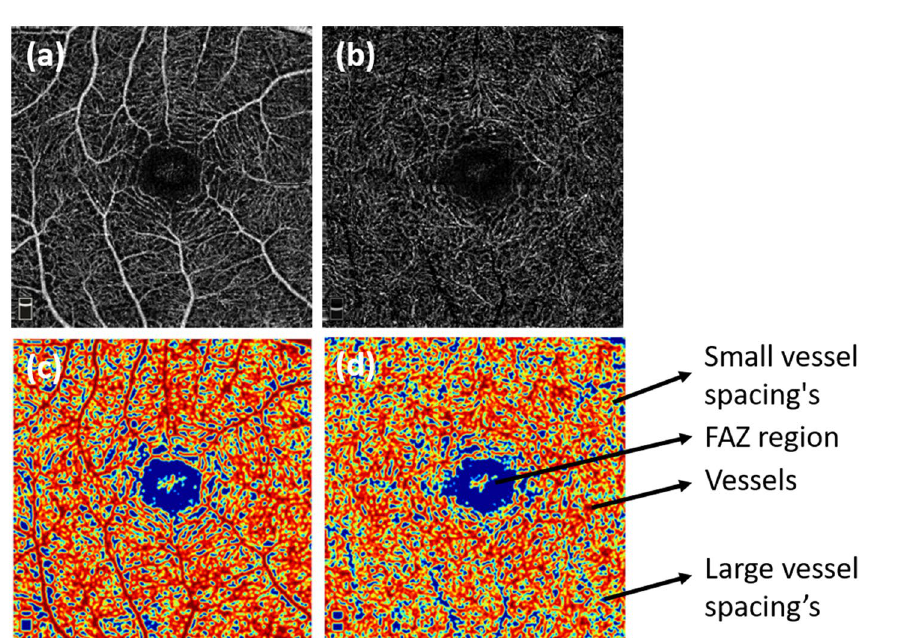
Figure 2. Optical coherence tomography angiography (OCTA) image of superficial ( a ) and deep layer after removal of projection artifacts ( b ). ( c , d ) are the respective images after fractal analysis. Regions in red pixels correspond to vessels, blue corresponds to large vessel spacing, and yellow corresponds to small vessel